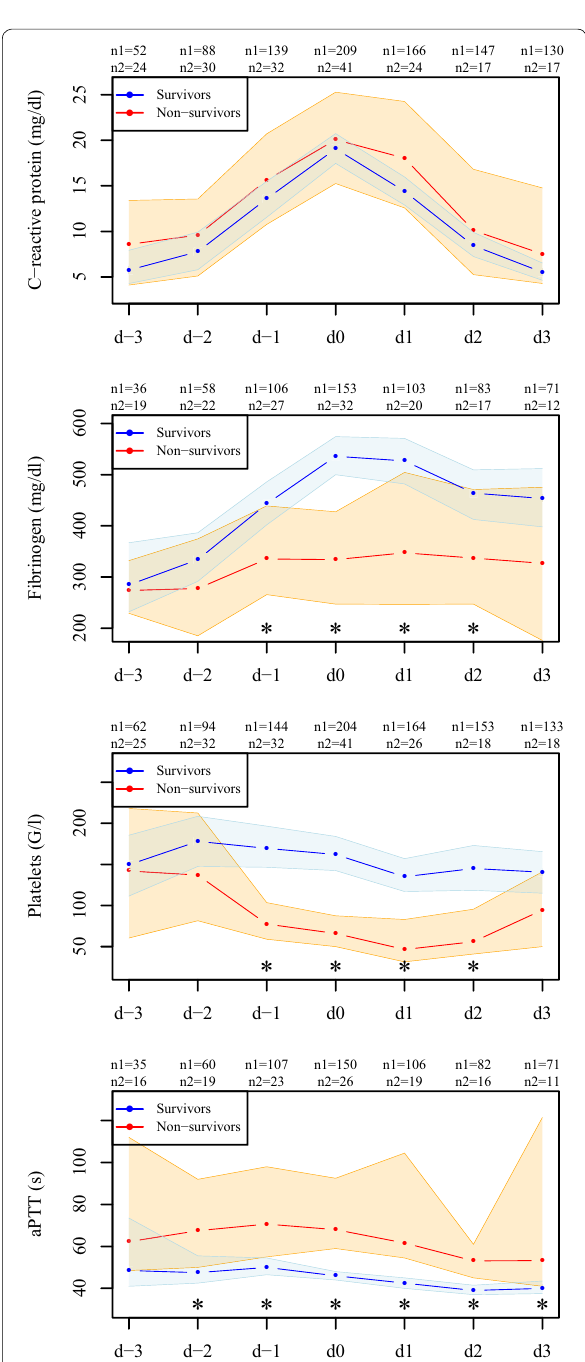
Fig. 1 Progression of C-reactive protein and measured coagulation parameters. Depicted are medians with 95% CIs of the measured parameters for survivors (blue) and non-survivors (red) from 3 days prior to (d-3 to d-1) until 3 days after (d1 to d3) C-reactive protein peaked (d0). Asterisks indicate significant differences between survivors and non-survivors at the respective time point; n 1 is the number of available measurements for survivors and n 2 for